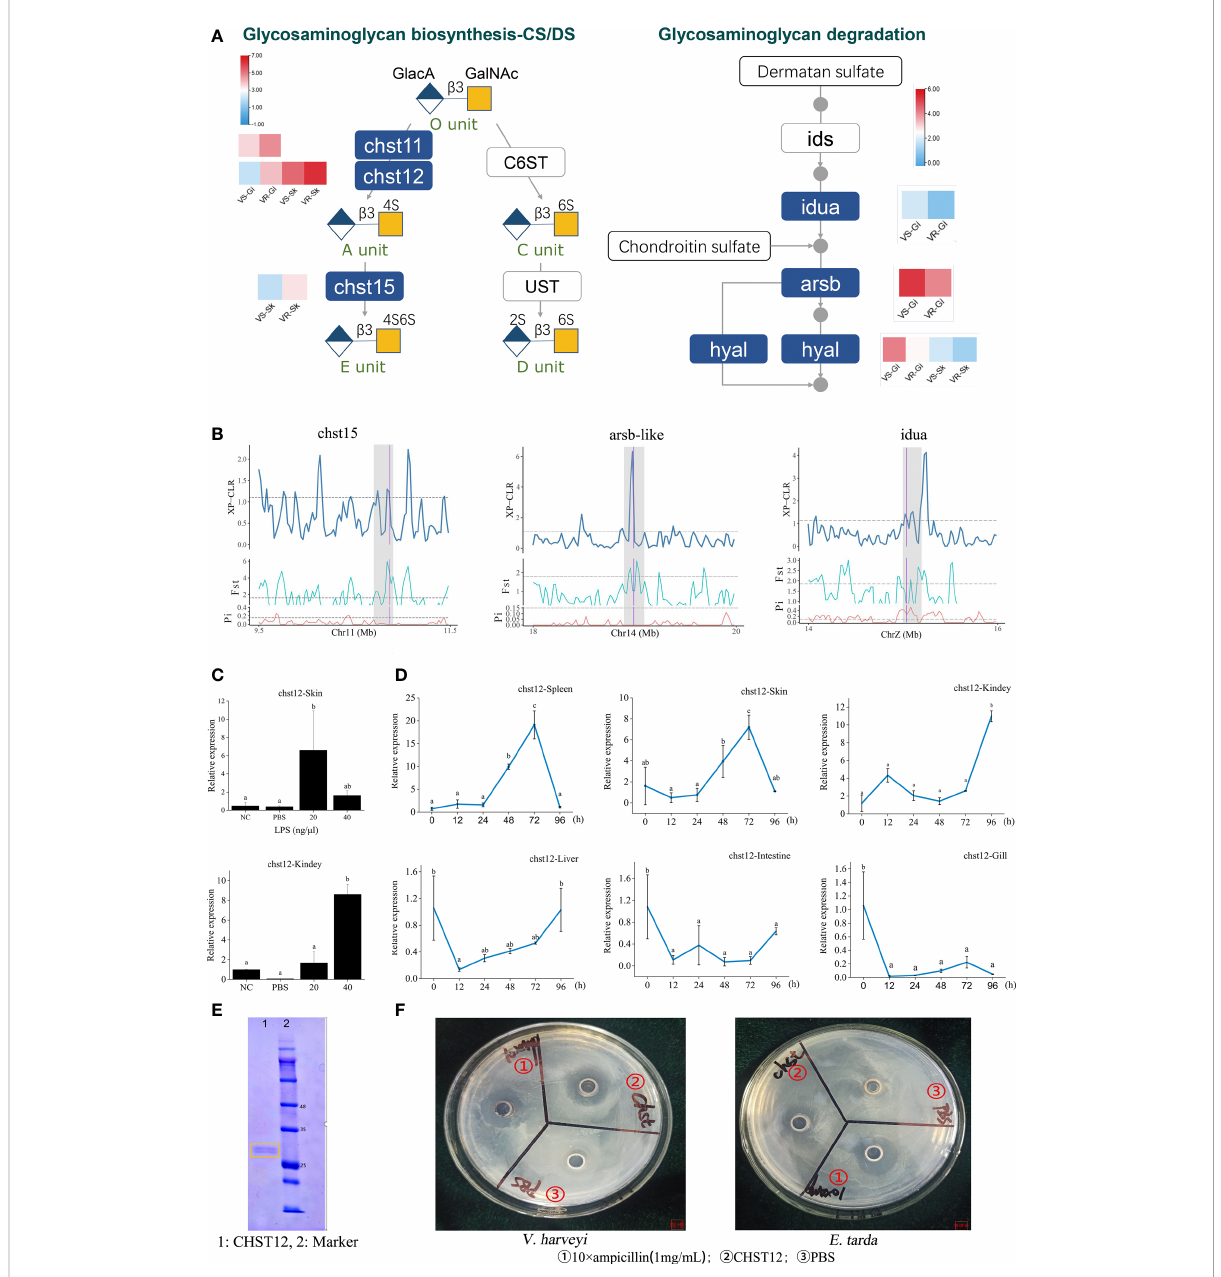
FIGURE 3 Identi fi cation of glycosaminoglycan CS/DS metabolism that contribute to improvement of vibriosis resistance. (A) Schematic diagram of pathways for biosynthesis (right panel) and degradation (left panel) of CS/DS chains. Heatmaps show the signi fi cantly different expression levels of the genes in the resistant (VR) and susceptible (VS) families. Gi: gill, Sk: skin. Ids: iduronate 2-sulfatase; Ust: uronyl 2-O-sulfotransferase; C6ST: chondroitin 6-O-sulfotransferase-1. O unit: GlacA-GalNAc, A unit: GlacA-GalNAc(4S), C unit: GlacA-GalNAc(6S), D unit: GlacA(2S)- GalNAc(6S), E unit: GlacA-GalNAc(4S, 6S). 2S, 4S, and 6S represent the 2-O-, 4-O-, and 6-O-sulfate group, respectively. GalNAc: N - acetylgalactosamine, GlcA: glucuronic acid. (B) chst15 , arsb-like and iuda genes in glysosaminoglycan metabolism pathways were embedded in selective sweeps. The XP-CLR, F ST and qp ratio values are plotted. Genomic regions located above the dashed line (corresponding to the top 5% values) were termed as strong selective sweeps for the post-selection individuals (grey regions). The boundaries of genes are marked in purple. (C) Relative expression levels of chst12 gene after LPS stimulation, with respect to its background expression levels in kidney and skin cells, respectively. Cells were treated with LPS at 28°C for 2h. (D) Time-course relative expressions of chst12 gene in skin, gill, spleen, liver, kidney and intestine after V. harveyi infection. Data are means ± S.D., representing average values of three replicates. Different words indicate signi fi cant differences ( p < 0.05). (E) Analysis of recombinant Chst12 by 12% SDS-PAGE. (F) Antimicrobial activity of recombinant Chst12 against V. harveyi and E. tarda using Oxford cup